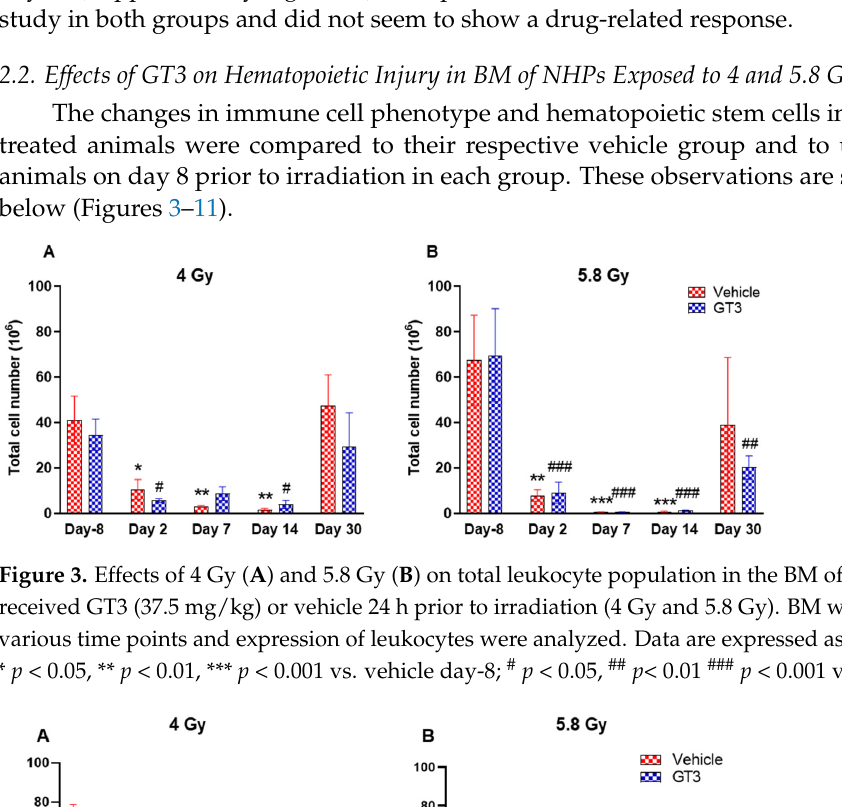
Figure 5. Effects of 4 and 5.8 Gy on CD34 percentages (A and B) and total cell counts (C and D) in BM of NHPs. NHPs received GT3 (37.5 mg/kg) or vehicle 24 h prior to irradiation (4 and 5.8 Gy). BM was collected at various time points and expression of CD34 + cells (5A-B) and total number (5C- D) were analyzed. Data are expressed as mean ± SEM. * p < 0.05, ** p < 0.01 vs. vehicle day-8; # p < 0.05 vs. GT3 day-8.